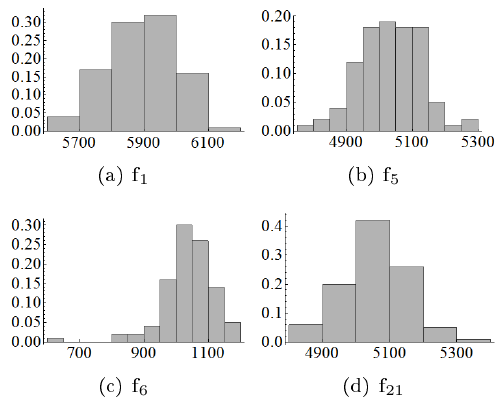
Fig. 5: The node out-strength distribution in the four aggregated networks generated on the basis of the jDE dynamics.